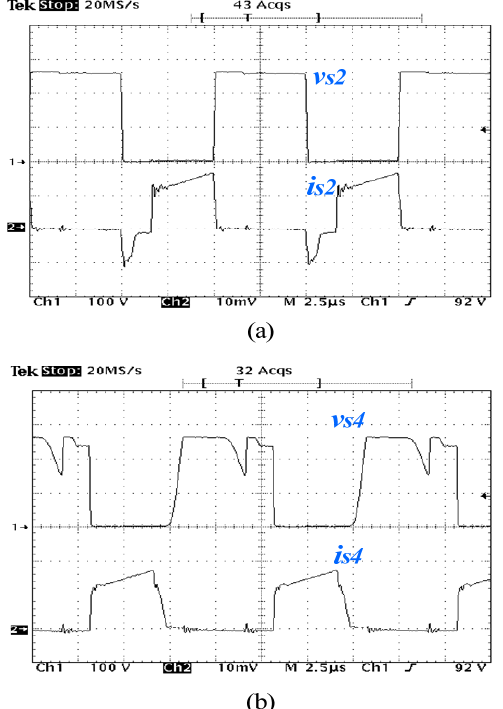
Figure 9. Experiment waveforms of the prototype at E = 260 V, E o = 50 V, I o = 10 A. ( v s .: 100 V/div., i s : 2 A/div., time scale: 2.5 μ s/div). ( a ) Switch S 2 current and voltage ( b ) Switch S 4 current and voltage.